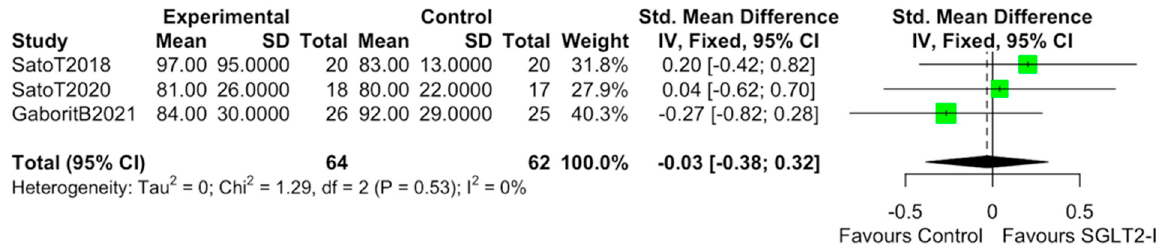
Figure 7. Effect of SGLT2-i therapy on LDL. Fixed − effects, standardized mean difference (SMD), 95% confidence intervals (CI), and I2 statistics. Table 2. Quality assessment (NOS).